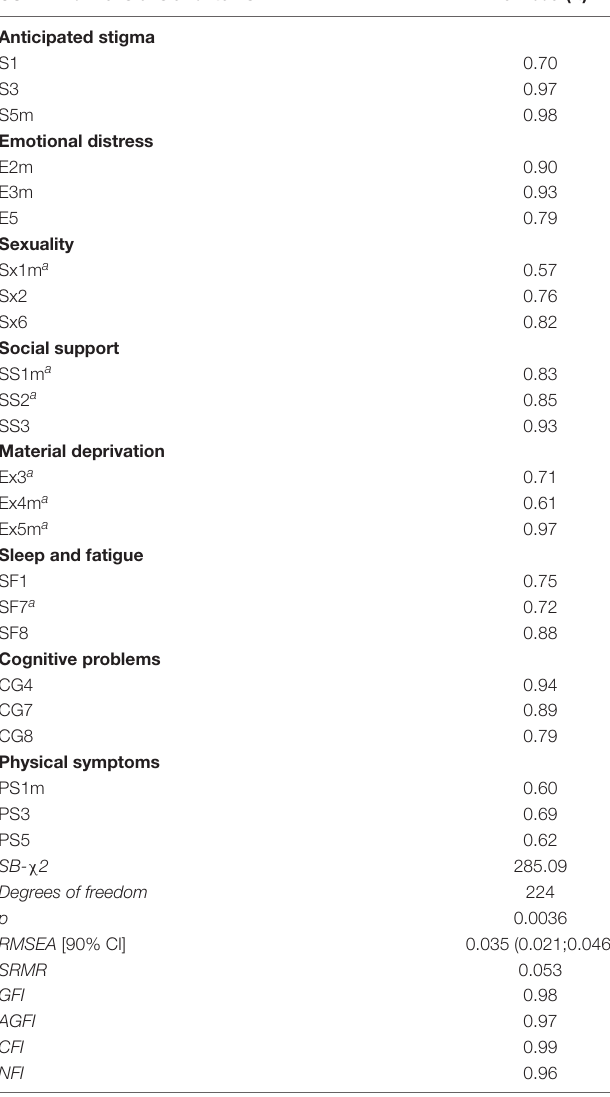
TABLE 4 | Standardised estimations for the first-order confirmatory factor analysis model. CST-HIV dimensions and items